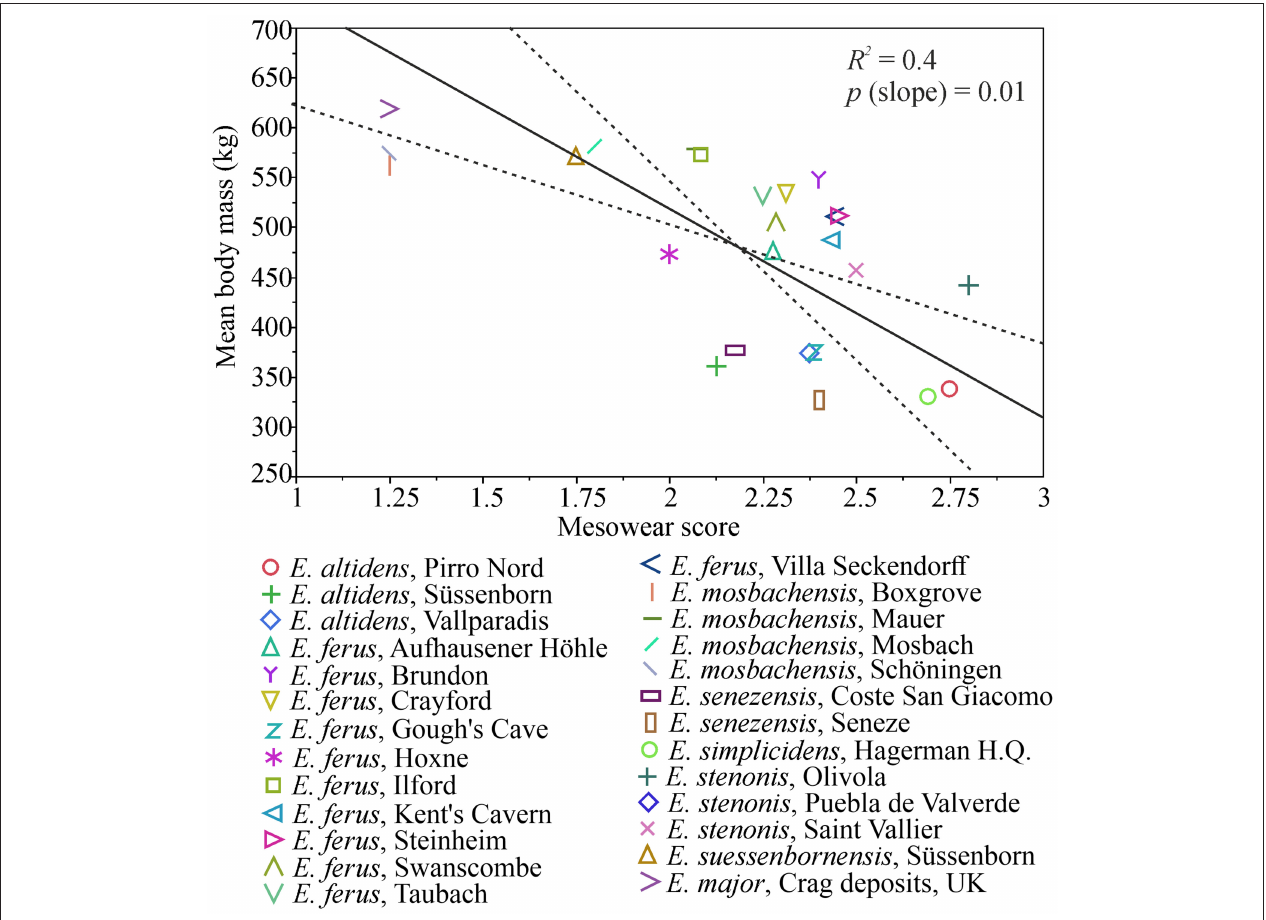
FIGURE 6 | Ranged major axis (RMA) regression of mesowear and body mass in Pleistocene European Equus (and E. simplicidens ). The regression line is drawn as a solid line and the dashed lines mark 95% confidence limits. There is a significant inverse relationship of body mass to increasingly grass-dominated mesowear, which is, however, driven by the very large, browsing species (see Figure 7 ). Increasing mesowear score indicates increase in the proportion of grass in diet (Saarinen et al.,